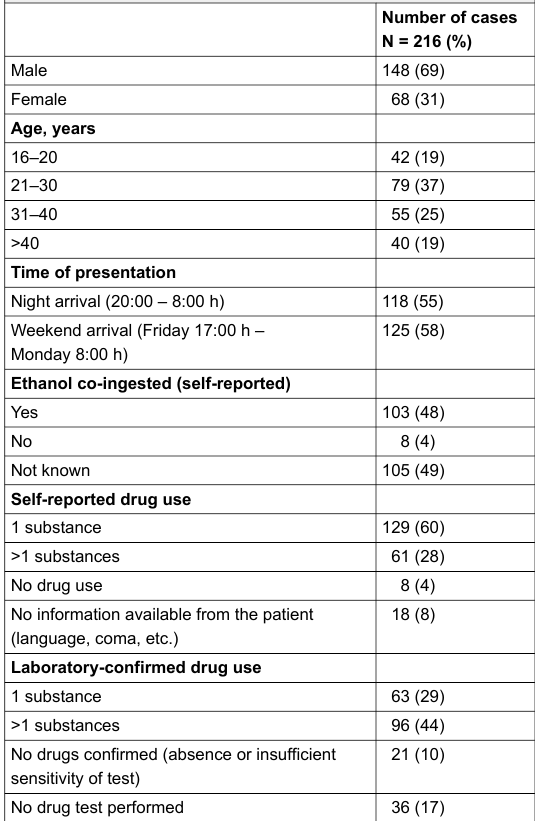
Table 1: Patient